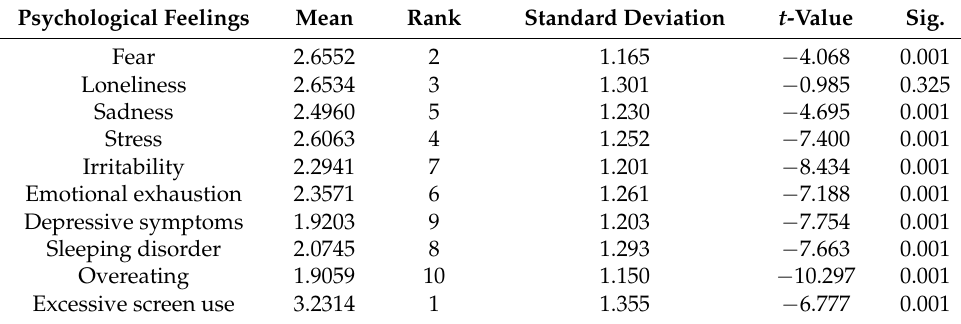
Table 2. Psychological feelings during the pandemic.